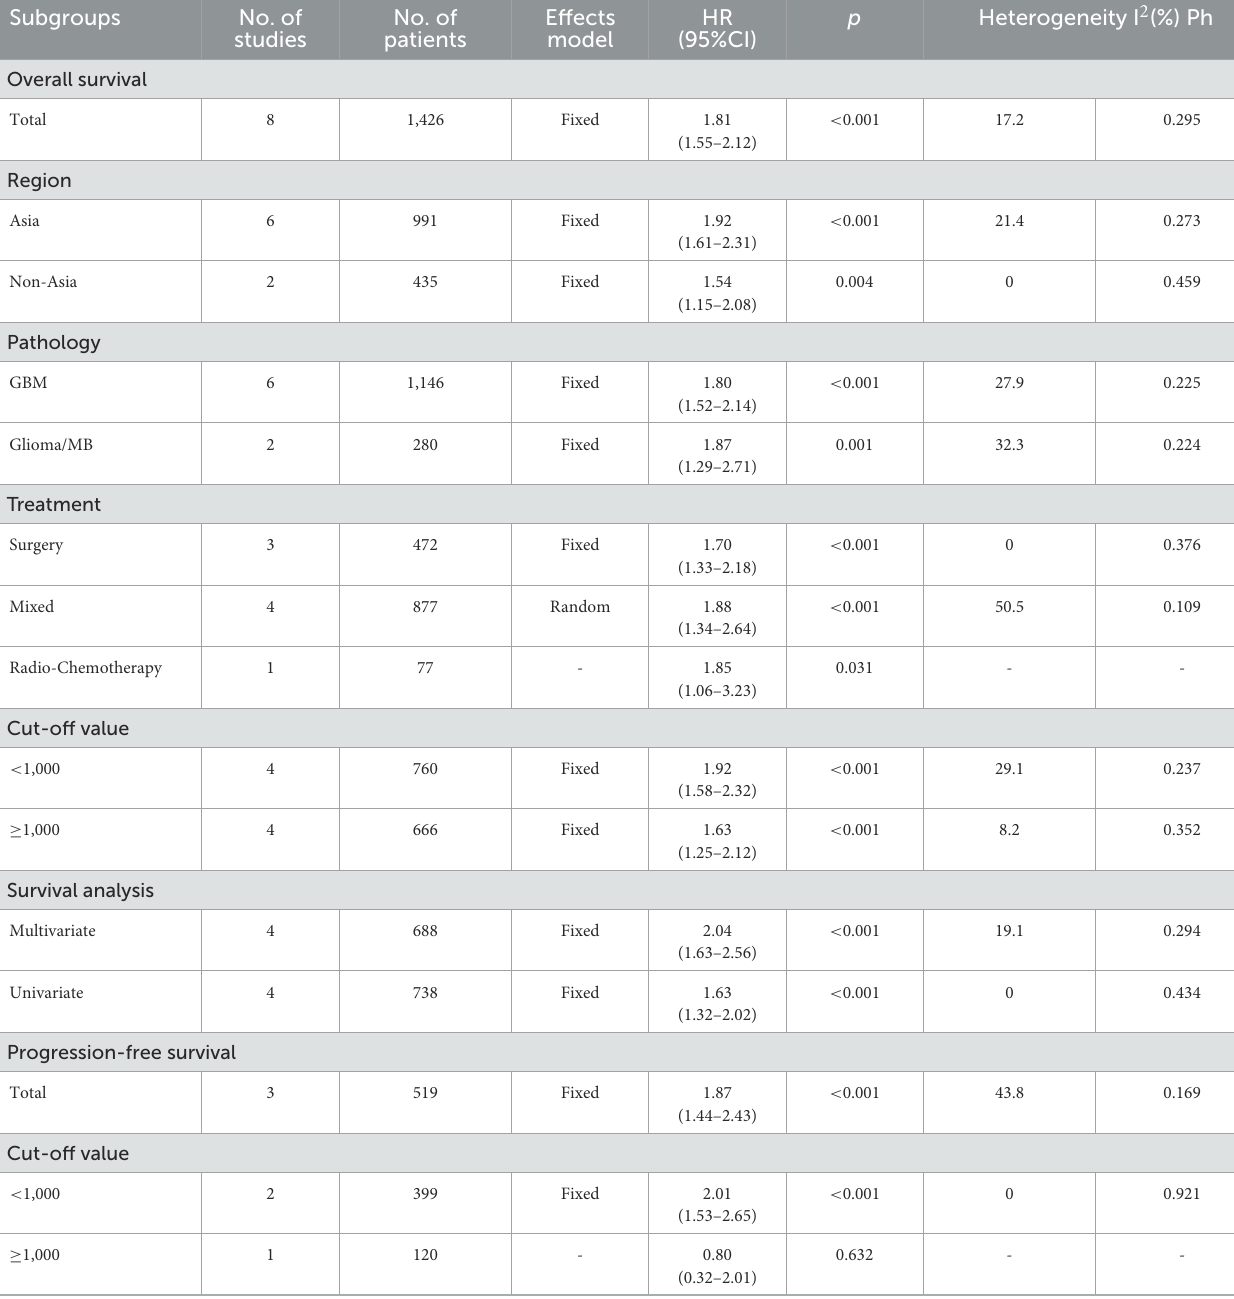
TABLE 2 Subgroup analysis of the prognostic value of SII for OS and PFS in patients with glioma.